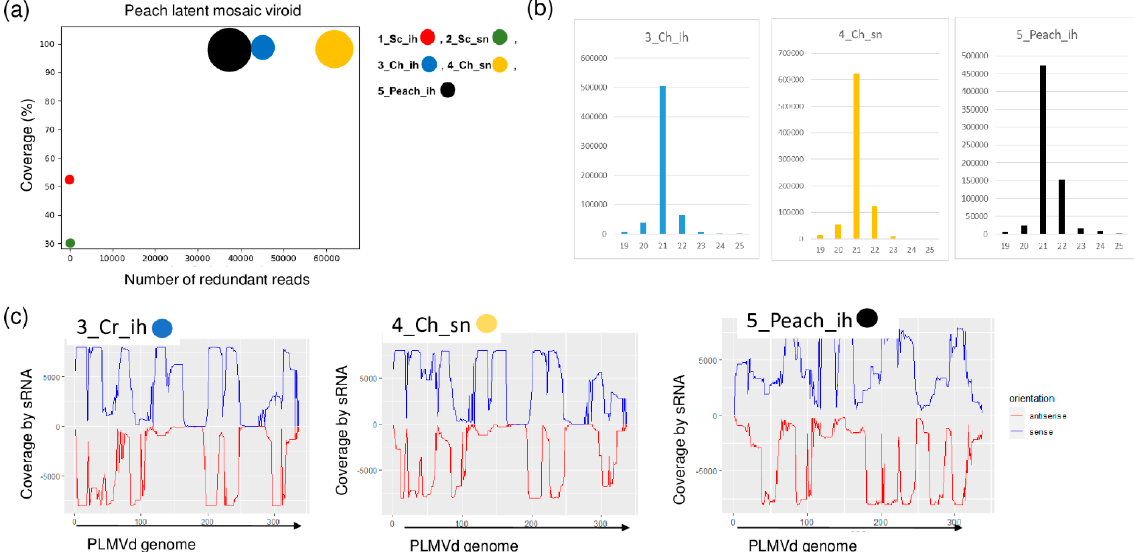
Figure 7. The result of the sRNA HTS and its validation for PLMVd in the five sRNA libraries. ( a ) The graphic representation of the result of the bioinformatics analysis of sRNA HTS. The coverage of the PLMVd genome ( y -axis) together with the number of RPM (number of PLMVd-specific non- redundant reads in 1 million sequenced reads on the x -axis) was plotted as a circle whose diameter is proportional to the number of contigs. Different colors were used for the five libraries, as indi- cated. ( b ) The size class distribution of the PLMVd-derived reads in 3_Ch_ih, 4_Ch_sn and 5_Peach_ih libraries ( c ) PLMVd-derived reads in 3_Ch_ih, 4_Ch_sn and 5_Peach_ih libraries are shown as they mapped to the PLMVd genome, indicating their sense and antisense origin (Sc: Springcrest; Ch: Cresthaven; ih: isolator house; sn: stock nursery). The presence of PLMVd was validated by both RT-PCR and Northern blot hybridi- zation (Figure 8).